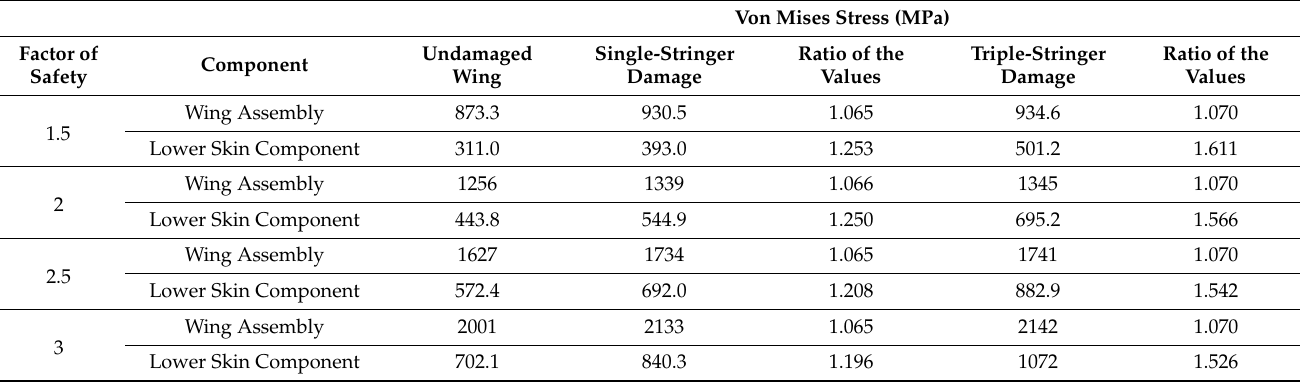
Table 10. Comparison of von Mises stress in the undamaged wing and wing containing stringer damage.